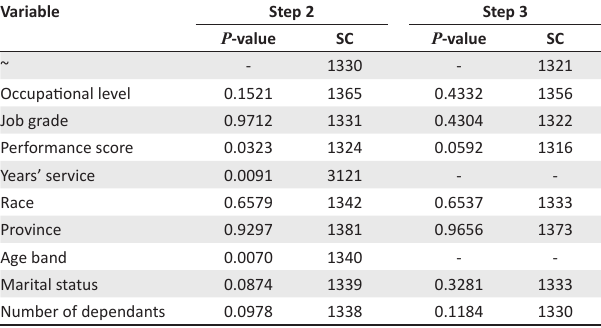
TABLE 3: Variable selection with Schwarz criterion. Variable